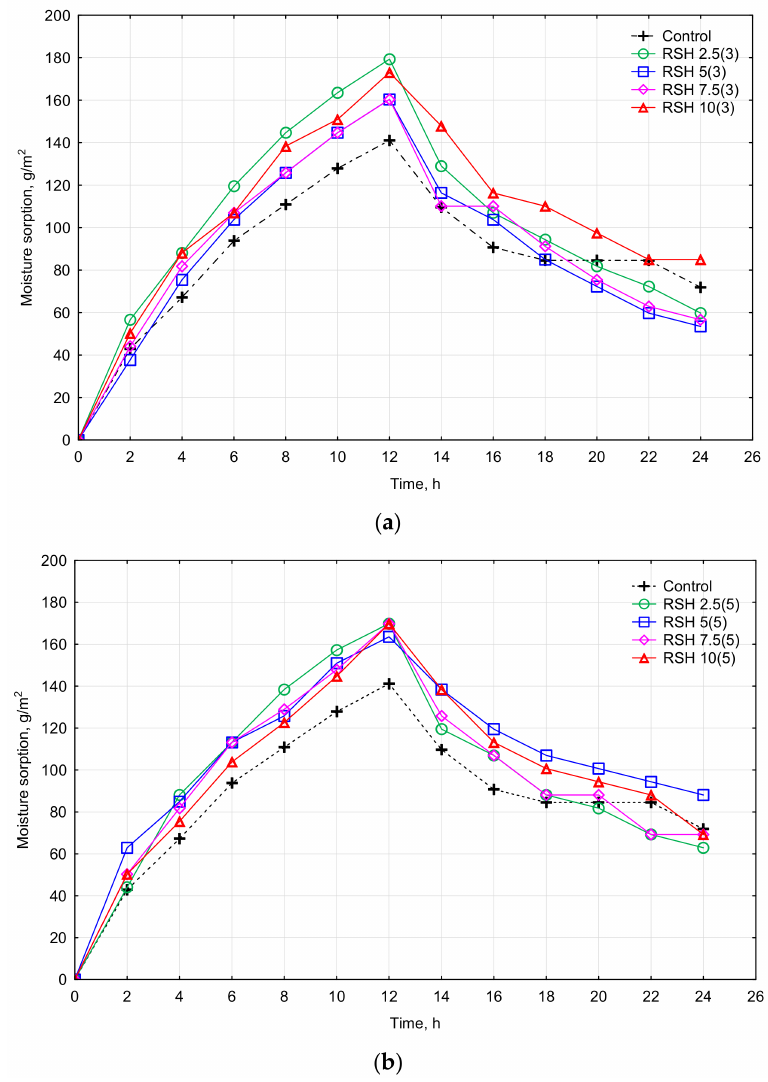
Figure 7. Moisture sorption of stabilized clay composites: ( a ) RSH heat-treated for 3 h and ( b ) RSH heat-treated for 5